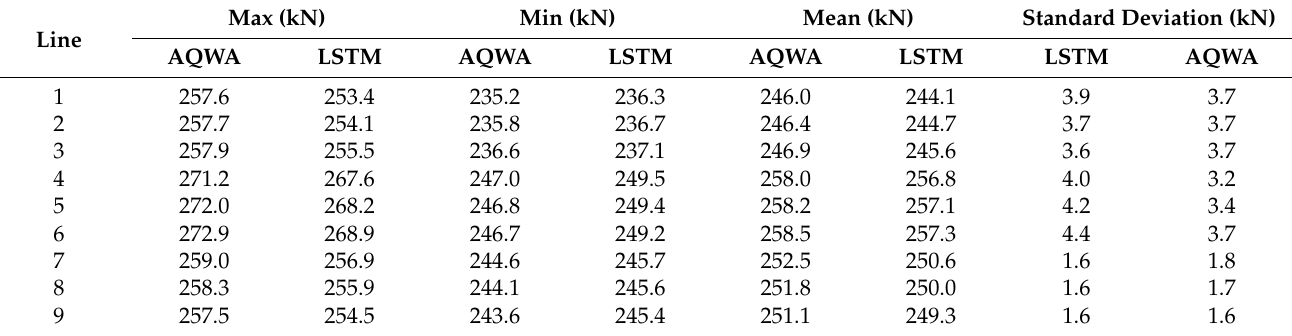
Table 14. Result statistics of AD7.